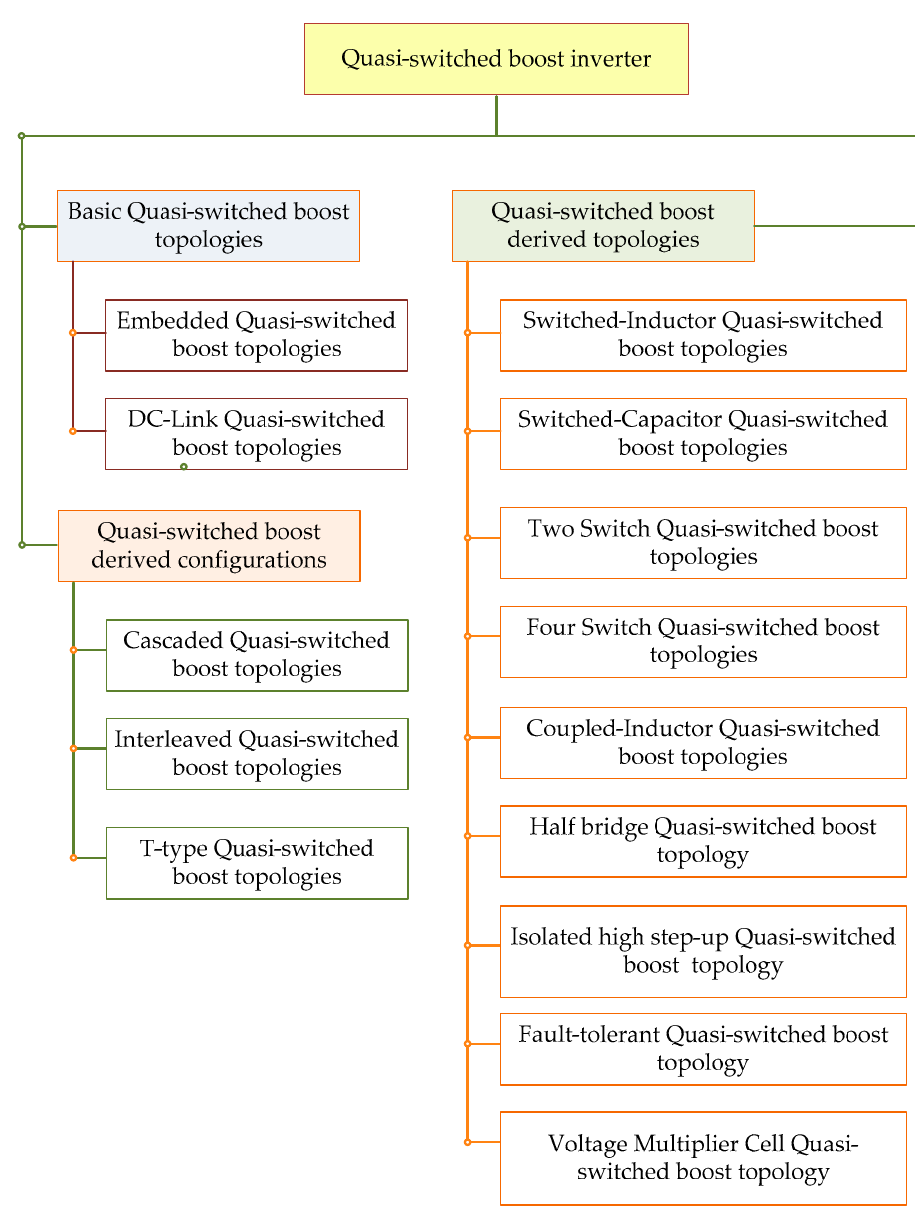
Figure 6. Quasi-switched boost derived topologies and configurations. A switched-inductor derived qSBI topology (SL-qSBI) is presented in [38], with a switched-inductor cell added to the qSBI topology to increase the DC voltage gain. The SL cell is one of the most extensively used techniques to improve the voltage gain. Compared to the SL-ZSI topologies, the SL-qSBI has reduced losses due to reduction in the passive components size and offers high boost inversion ability. The SL-qSBI has the drawback of higher input current ripple compared to the traditional qSBI. In [39], an improved switched inductor qSBI topology (cSL-qSBI) is proposed with a modified switched inductor structure. The SL-qSBI and cSL-qSBI topologies are shown in Figure 7a,b. The cSL-qSBI has the benefit of reduced input current ripples compared to the SL-qSBI topology. The cSL-qSBI is derived from the SL-qSBI by connecting one inductor of the switched-inductor cell in series with the input source and has the same number of components as SL-qSBI. The presented topology features a simpler structure with high voltage DC gain and enhanced power density. The cSL-qSBI operated in DCM when the diode D5 current drops to zero in the second active state. In order to avoid this DCM for operation with low